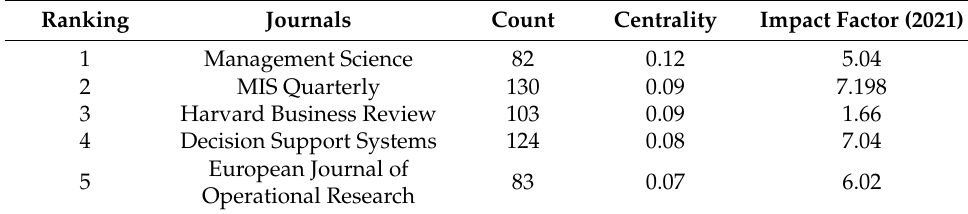
Table 3. The top 5 co-cited journals according to centrality.